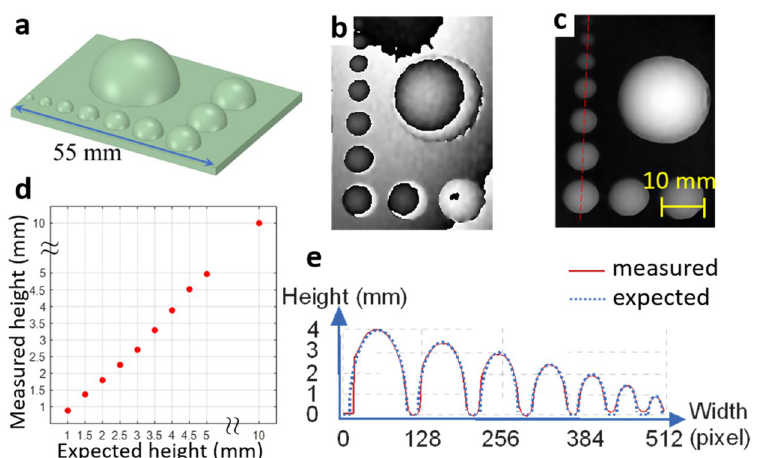
Figure 6. Axial resolution test. ( a ) CAD model of the axial resolution target consisting of ten hemispheres of different radius (10, 5, 4.5, 4, 3.5, 3, 2.5, 2, 1.5, and 1 mm). ( b ), ( c ) Wrapped and unwrapped phase maps, respectively. ( d ) Measured heights of the hemispheres against the expected values. ( e ) Measured height corresponding to the red dashed line in ( c